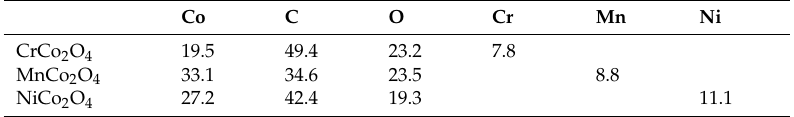
Figure 3. ( a ), ( b ), and ( c ) shows EDX mapping of tubular MCo 2 O 4 (M = Cr, Mn, Ni) structures, respectively. Table 2. Elemental composition in wt % for MCo 2 O 4 (M = Cr, Mn, Ni) obtained using energy dispersive X-Ray analysis (EDX). The elemental composition is approximately determined using EDX. Ideally, EDX can prove which elements are abundant in the particles, but not obtain the exact chemical